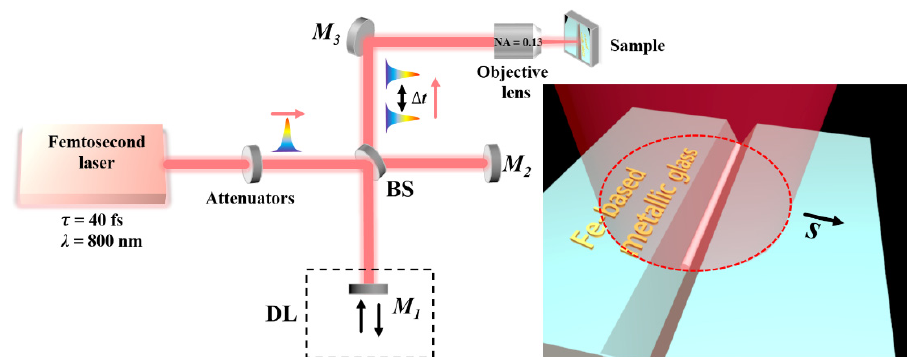
Figure 1. Schematic diagram of the experimental setup for the sole long nanowire structure formation inside the pre-scratched groove on the surface of Fe-based metallic glass, upon irradiation of the temporally delayed femtosecond laser pulses. τ : pulse width; λ : central wavelength of laser; BS: beam splitter; DL: delay line; Δ t : delay time; M: reflector; S : direction of sample translation. In the experiment, a 40 μ m-thick foil of Fe-based metallic glass (Fe 85 Si 9 B 6 ) was selected